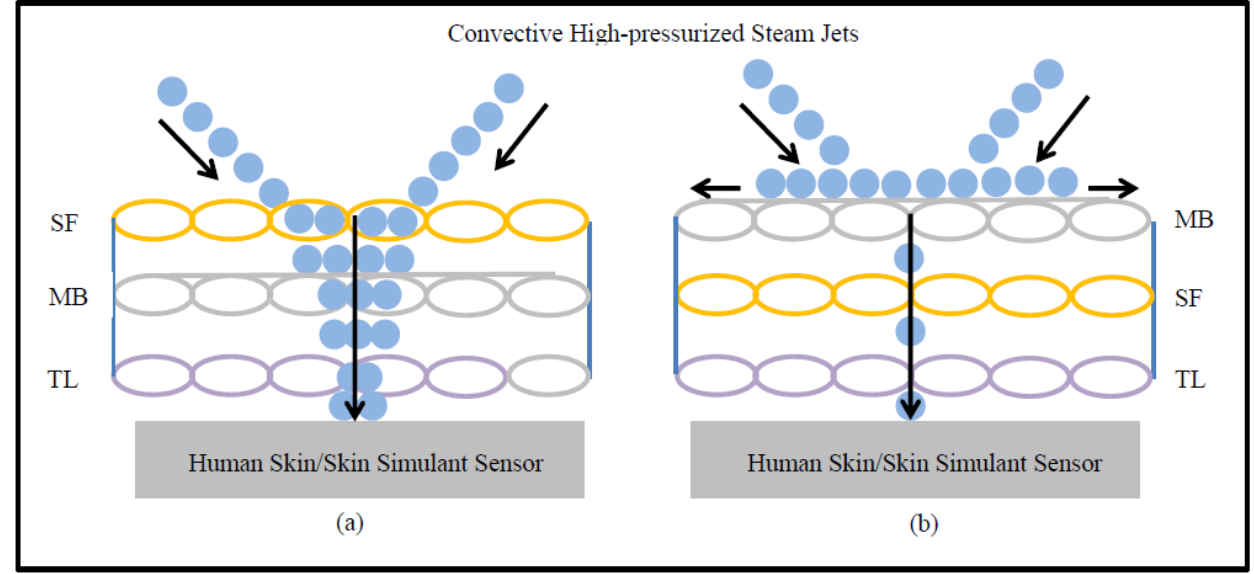
Figure 11. High-pressurized steam transfer through ( a ) a triple-layered fabric with SF in the outer layer, and ( b ) a triple-layered fabric with MB in the outer layer.